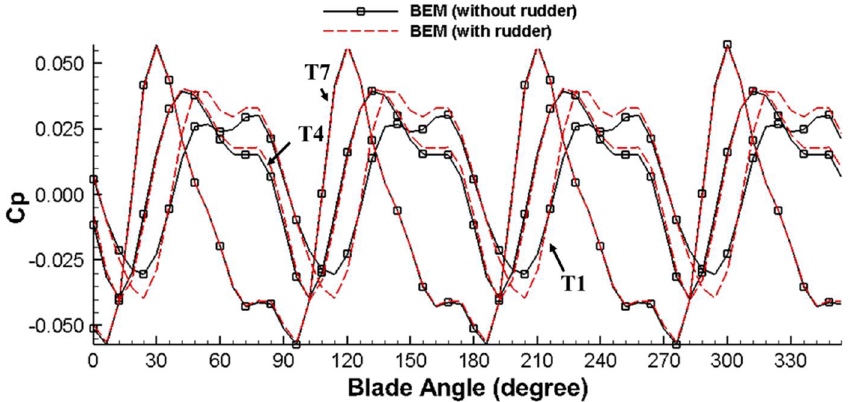
Figure 13. Study of the level of simplification on the rudder geometry in the pressure-BEM model. The blade-angle ranges between 0 and 2 π and is defined by the angle the blade has passed starting from the “upright position”. The “upright position” means the mid-camber point of the root section is located on the vertical axis above the hub (+ y axis).